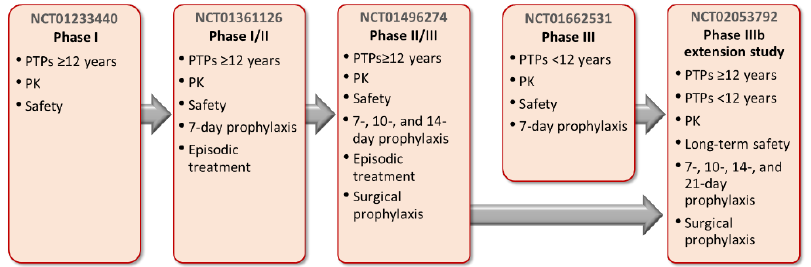
Figure 1. Overview of the PROLONG-9FP program. PK, pharmacokinetics; PTPs, previously treated patients.